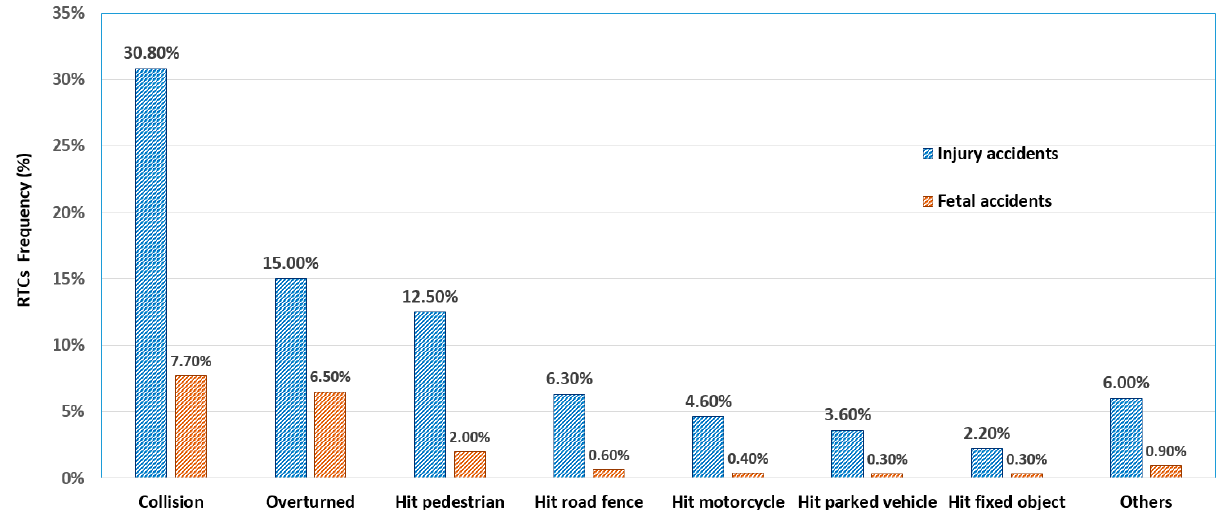
Figure 2. Frequency distribution of RTCs with types of crashes in the study area (adopted from [51]). Modeling Techniques